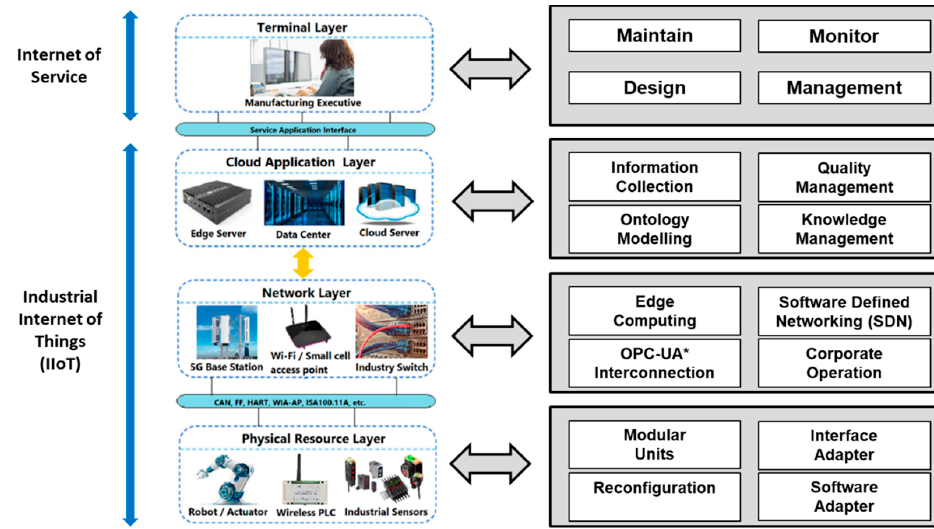
Figure 19. Hierarchical architecture of a smart factory (adapted from [71]).